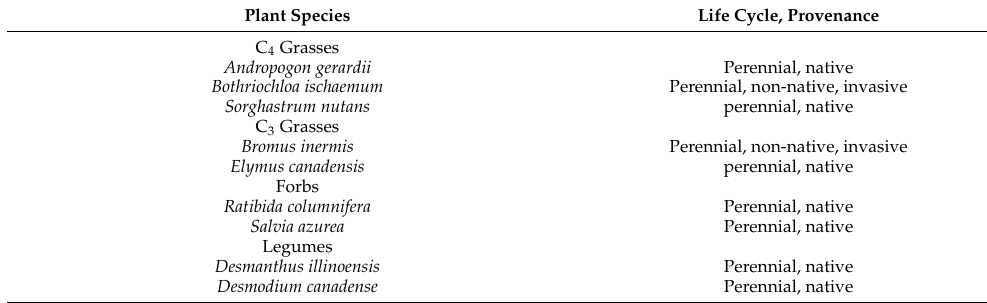
Table 1. Functional group, species, and status of common grassland plants selected for commercial arbuscular mycorrhizal (AM) inoculant experiments.